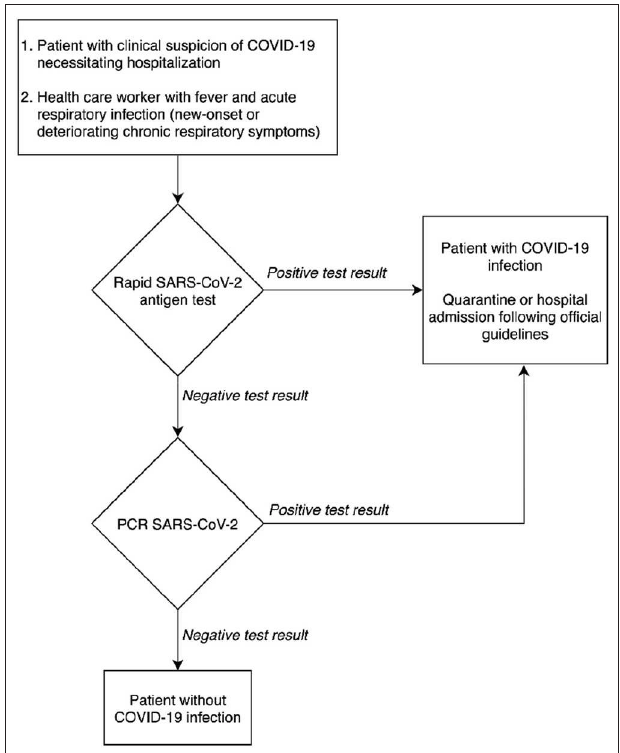
FIGURE 2 | Proposal for a diagnostic decision